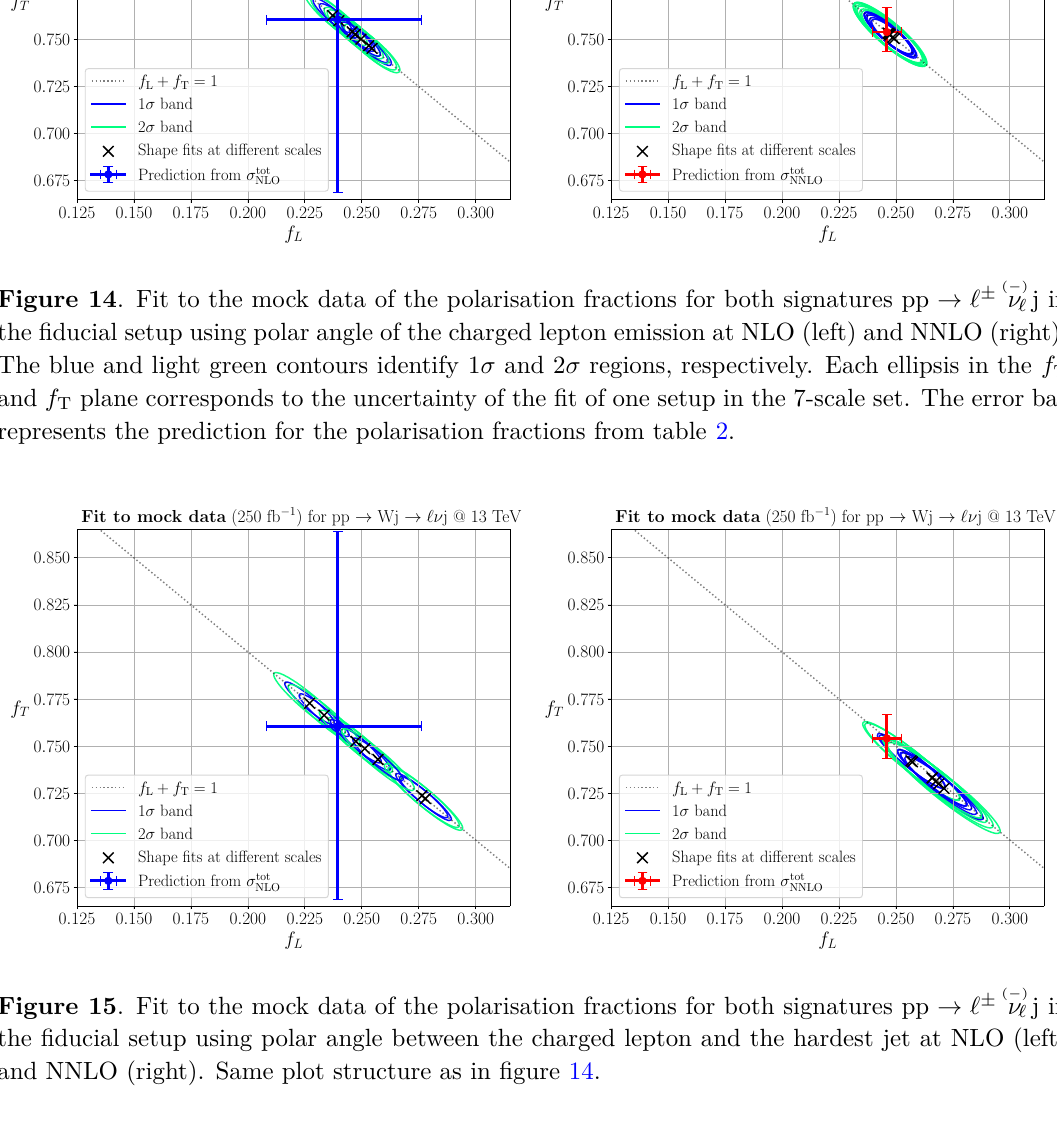
Figure 15 . Fit to the mock data of the polarisation fractions for both signatures pp → ‘ ± ( − ) ν ‘ j in the fiducial setup using polar angle between the charged lepton and the hardest jet at NLO (left) and NNLO (right). Same plot structure as in figure